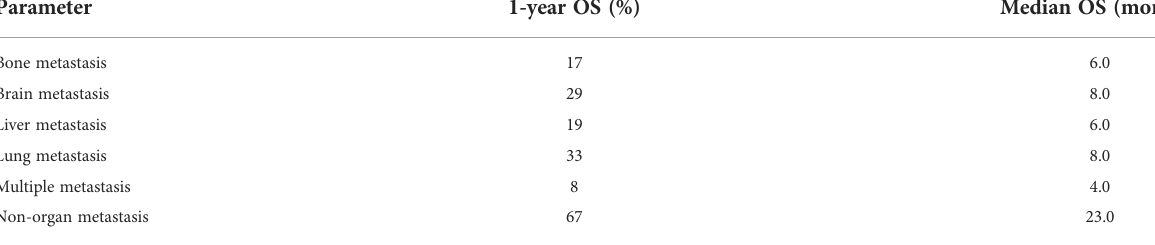
TABLE 2 Survival analysis of various metastatic